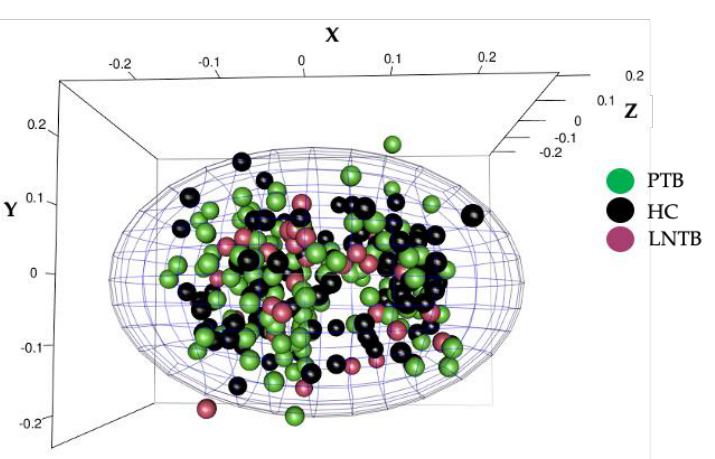
Figure 1. The study groups show homogeneity forming a tight cluster showing no stratification in the samples. Figure depicts a three-dimensional plot for checking population stratification among the study groups i.e., PTB (green spheres), LNTB (Purple Spheres) and HC (green Spheres). Raw Hamming distances as multidimensional scaling (MDS) co-ordinates are plotted on X, Y and Z-axes, to visualize genetic distance between the study groups.